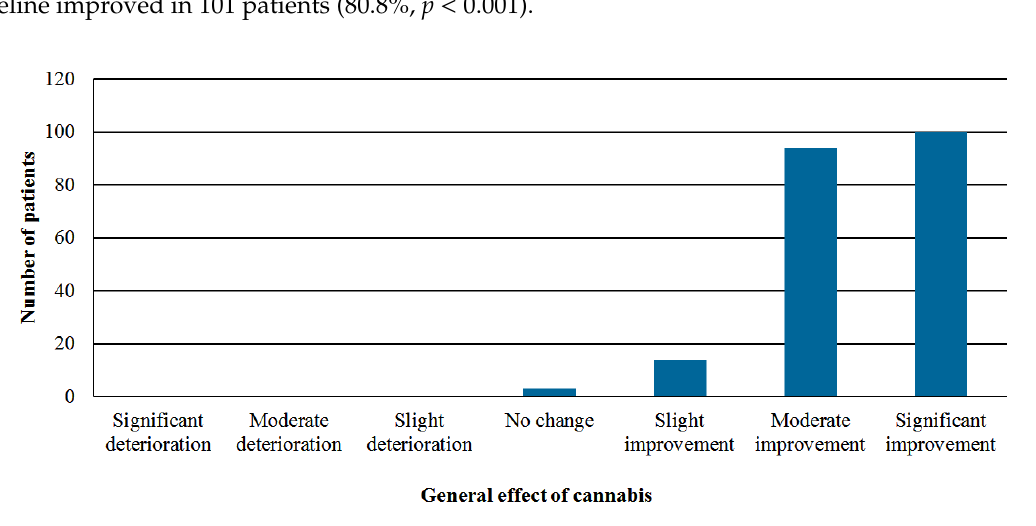
Figure 2. Perception of the general e ff ect of cannabis on the patient’s condition after six months of treatment.